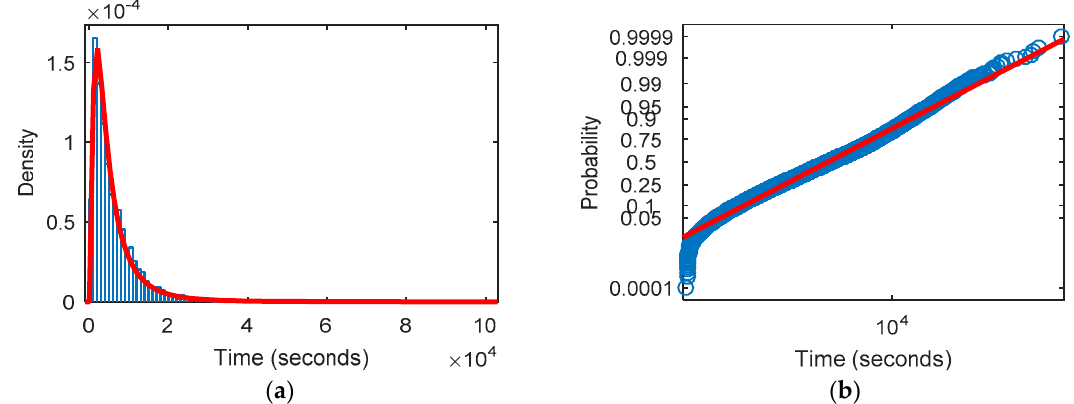
Figure 10. Probabilistic fitting for the yellow patient with a member problem diagnosis for: ( a ) density function; ( b ) probability plot. (red line — theoretical distribution, blue — hospital database).